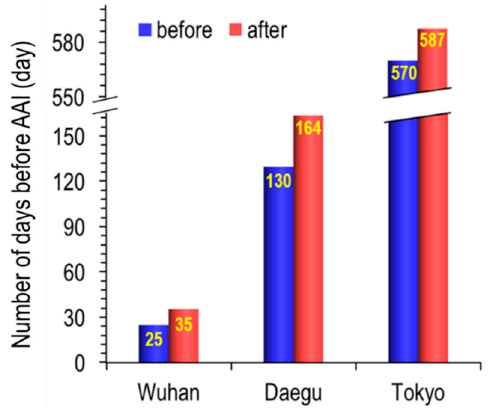
Figure 9. The number of days it takes to cause AAI by PM 2.5 exposure, before and after the city lockdown/self-reflection at each city.